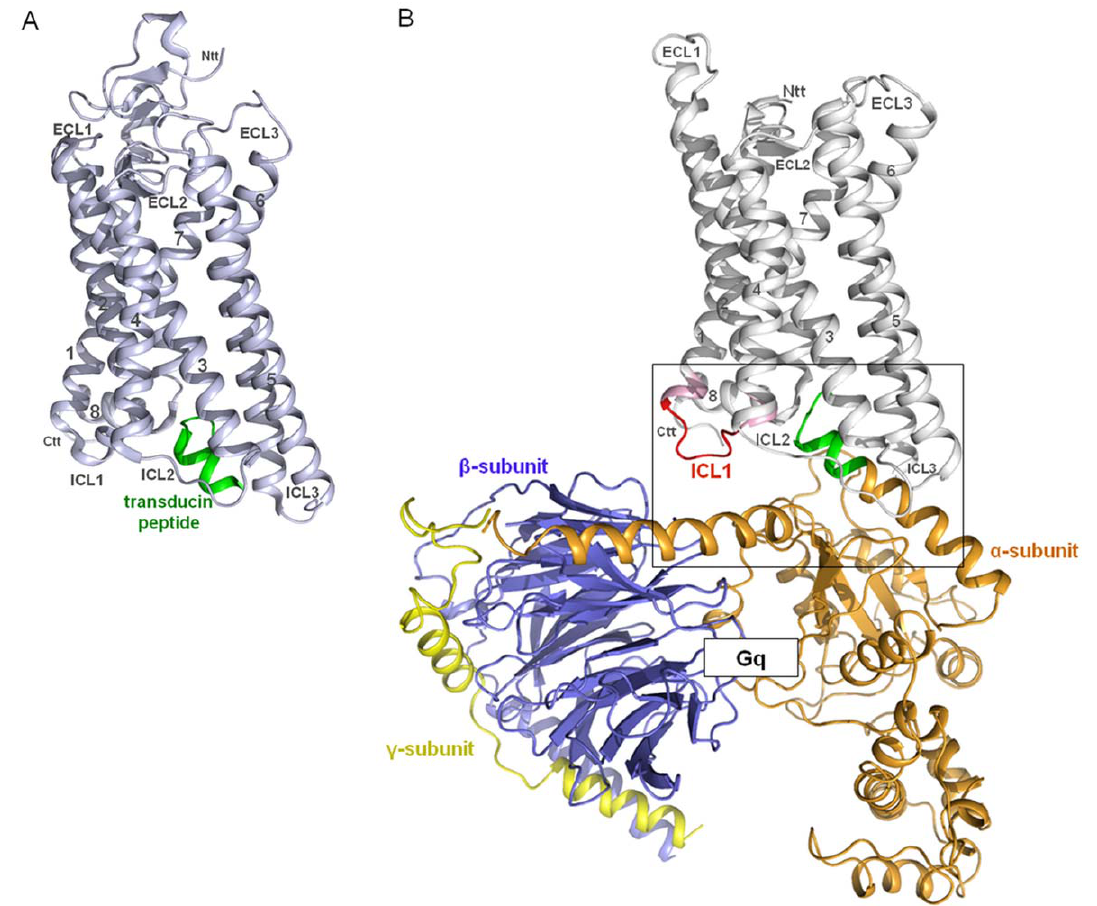
Figure 1. Opsin in complex with a transducin peptide. A ) The crystal structure of Opsin (light blue) in complex with a synthetic peptide (green) of the C-terminal region of transducin (G-protein) (PDB entry 3DQB) was used as a structural template to build B ) a homology model of the active TSHR conformation (without the N-terminal extracellular region) coupled with Gq heterotrimer (G a q bc ). The superimposition of the C-terminal residues (green) of the G a q -protein model with the helical fragment of transducin from the X-ray structure allows a reliable orientation of the complex.